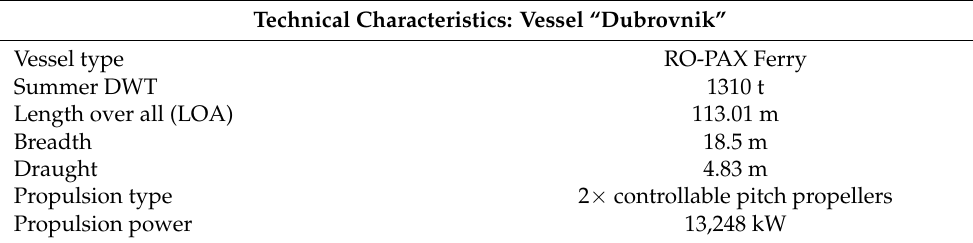
Table 14. Technical characteristics of the reference vessel “Dubrovnik”.